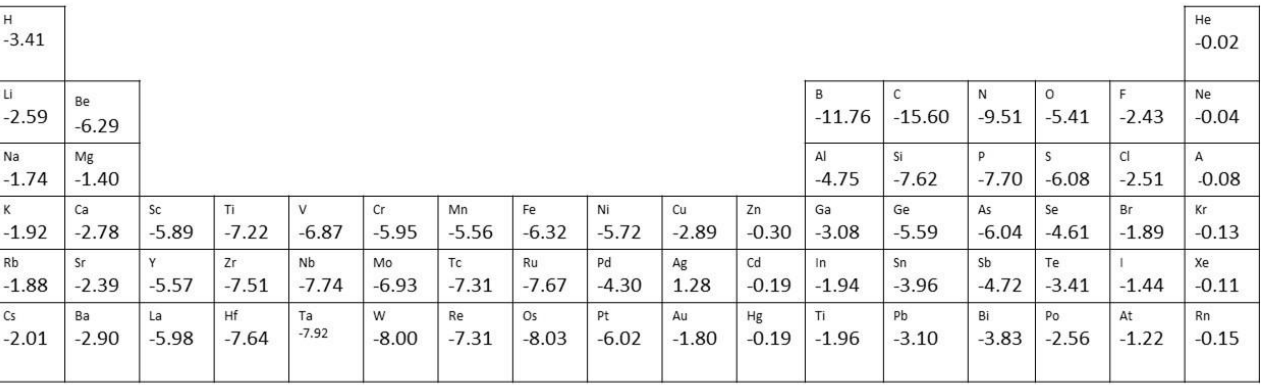
Figure 2. Adsorption energy (in eV/atom) for atoms at single vacancies of graphene calculated using WdW — DF2. Data were taken from Ref. [3].